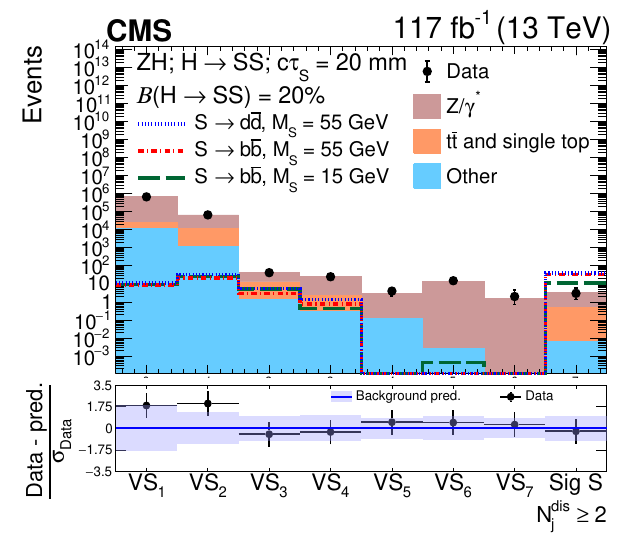
Figure 3 . The background estimate and the observed data in the N dis ≥ 2 bin, for each of the j seven validation samples (VS through VS ), along with the signal sample (Sig S). Signal model 1 7 distributions for scalar masses of 15 and 55 GeV with a proper mean decay length of 20 mm are also shown. The Higgs boson branching fraction to long-lived scalars ( B (H → SS) ) is set to 20%.